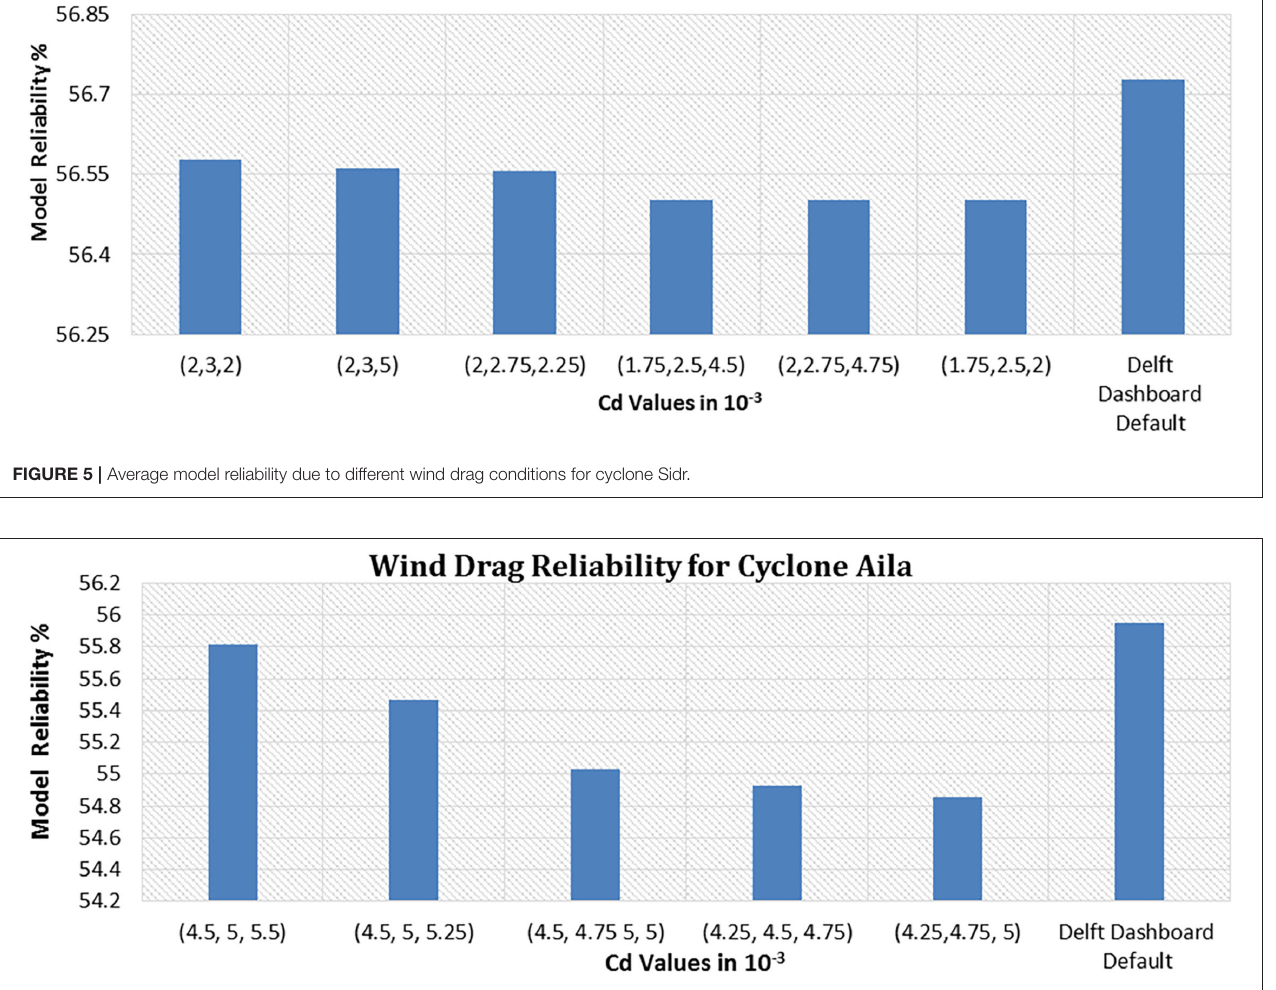
FIGURE 6 | Average model reliability due to different wind drag conditions for cyclone